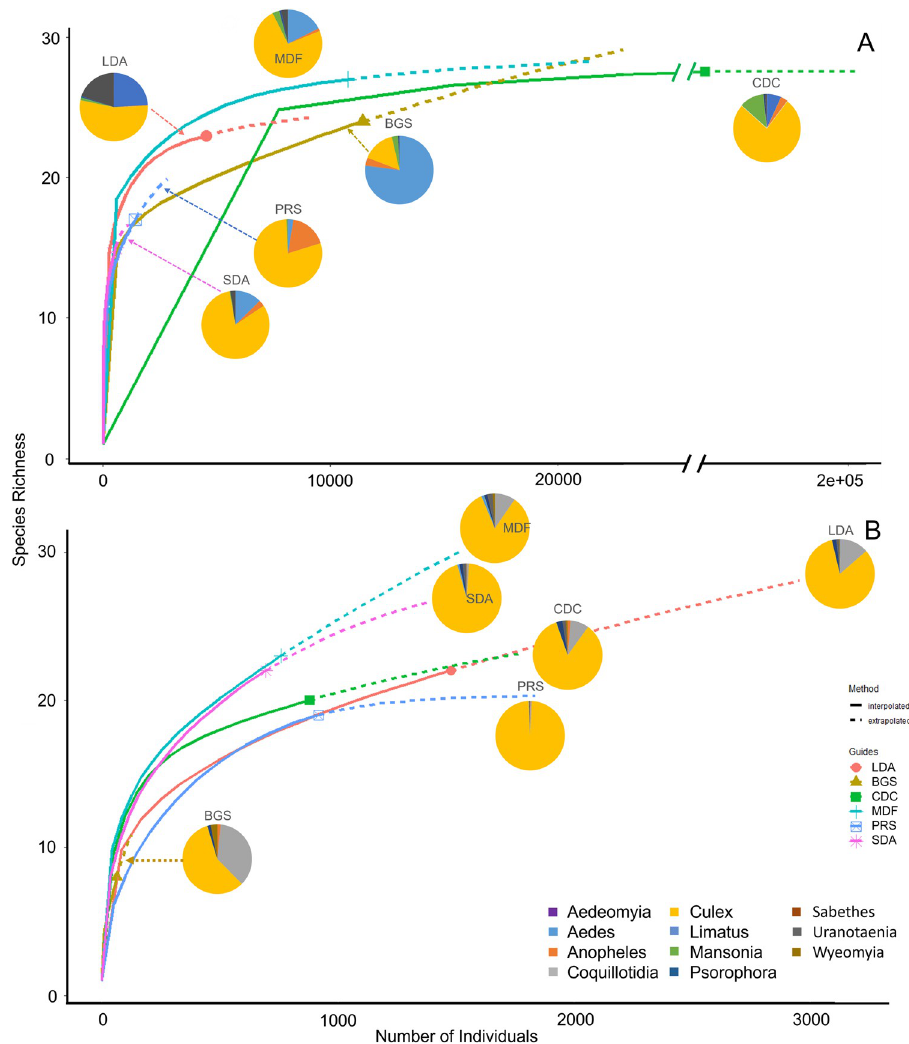
and the small diameter aspirator (SDA) in Florida and Panama. Species accumulation curves of mosquito species captured by the six traps used in Florida City, Florida (A), and Darie´n, Panama (B). Pie charts correspond to the distribution of mosquito genera captured in each